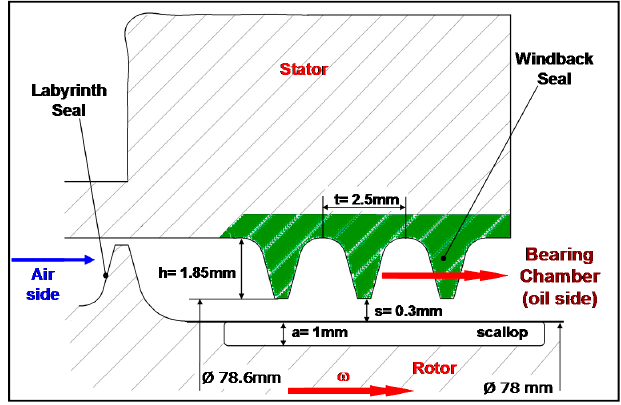
Figure 2. Dimensions of the baseline seal.